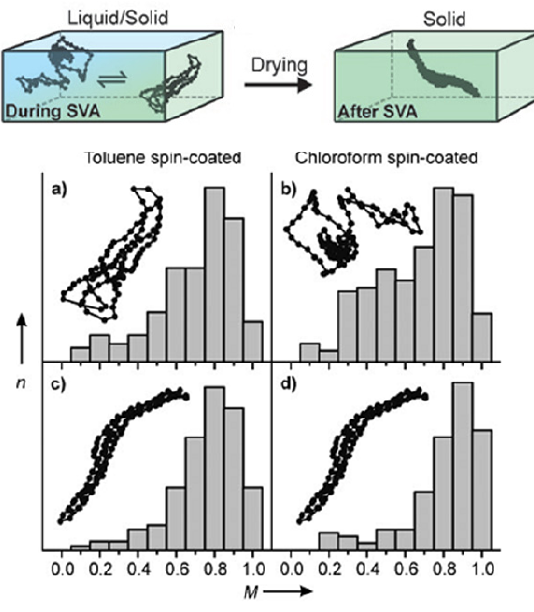
Figure 17. The schematic illustrations of equilibrium between coil-like and rod-like conformations in a (partly) dissolution state and the rod-like conformations in drying films after the coil-to-rod transition. The experimental histograms of modulation depth, M (larger M larger anisotropy), from single poly[2-methoxy-5-(2-ethylhexyloxy)-1,4- phenylenevinylene] (MEH-PPV) molecules embedded in a PMMA matrix with different preparation methods: Spin-coated from ( a ) toluene and ( b ) chloroform solution with a considerable retention of coil-like conformations in solution; ( c , d ) The film samples were additionally solvent vapor annealed for 60 min with toluene-saturated atmosphere with rod-like conformations prevailing. (Adapted with permission from [139]. Copyright 2011 Wiley-VCH